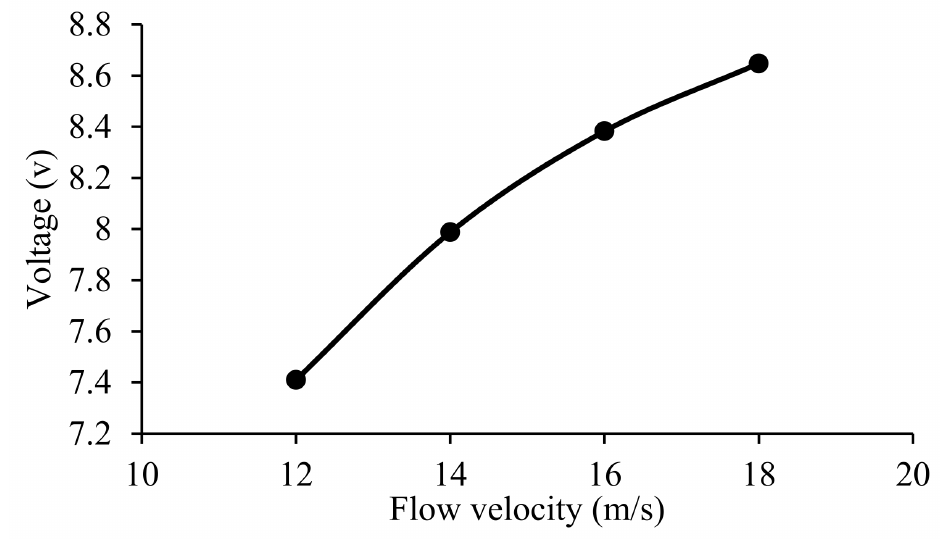
Figure 12. The relation between the flow velocity and output voltage.